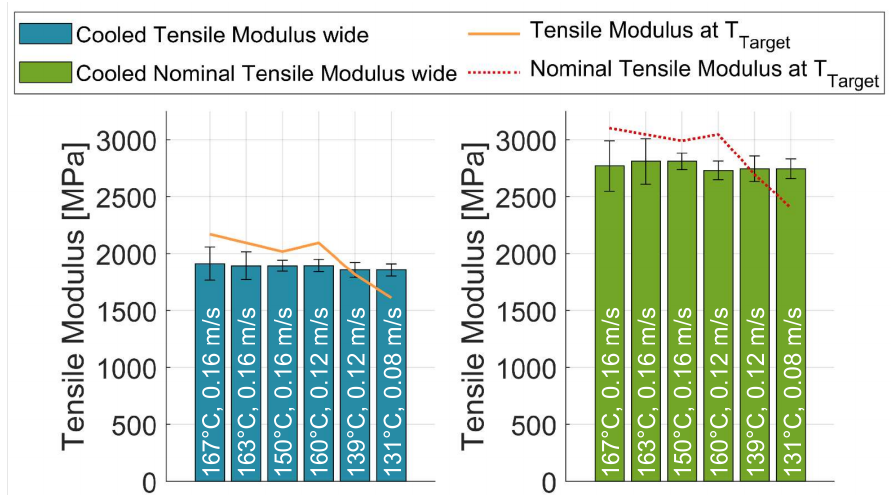
Figure 9. Standard and nominal transverse tensile modulus of the cooled specimens at 100 mm cooling distance with the reference tensile strengths for unheated specimens at the achieved heated temperatures.